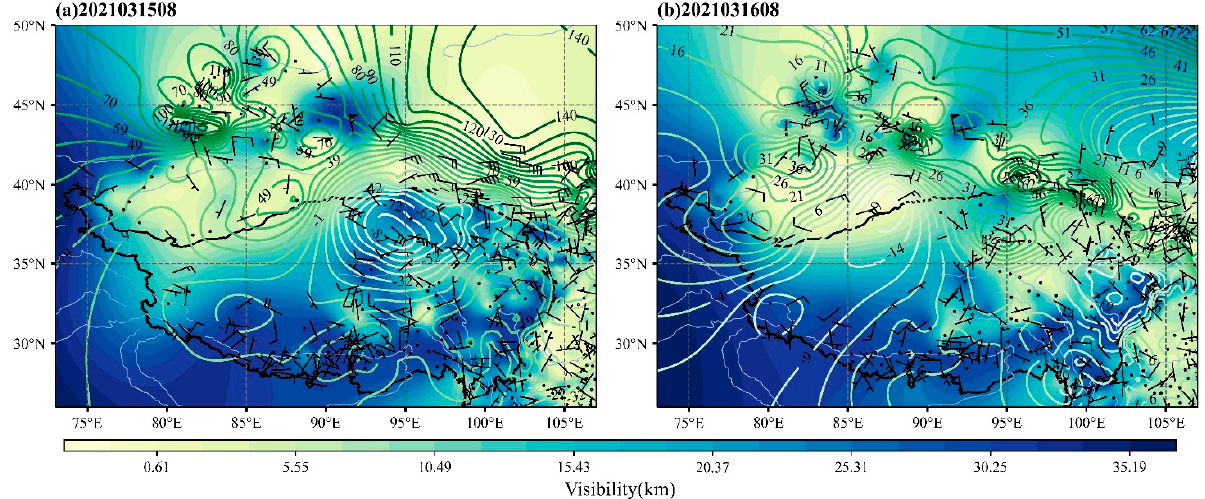
Figure 4. Superposition diagram of 24-h pressure change (isolines), wind field, and minimum visibility on surface. ( a ) 08:00, 15 March 2021; ( b ) 08:00, 16 March 2021.